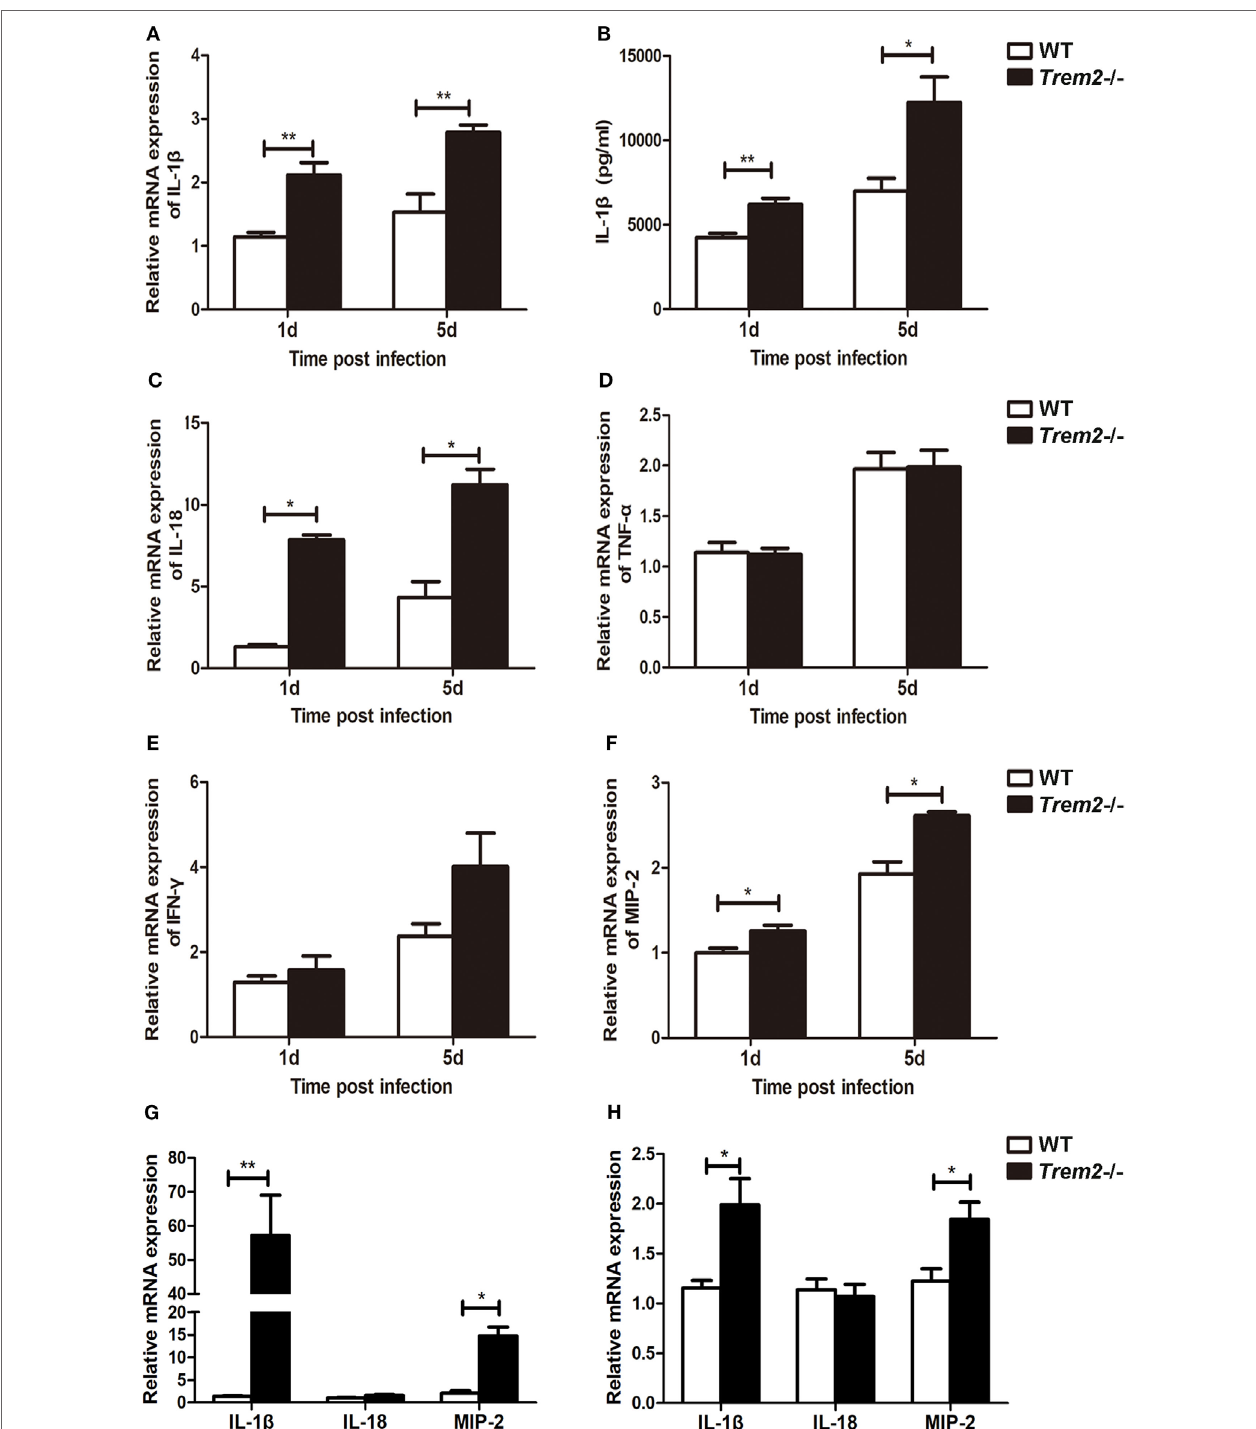
FigUre 2 | Triggering receptors expressed on myeloid cells 2 (TREM-2) inhibited pro-inflammatory cytokine expression after Pseudomonas aeruginosa infection. mRNA expression levels of pro-inflammatory cytokines, including IL-1 β (a) , IL-18 (c) , tumor necrosis factor-alpha (D) , IFN- γ (e) , and MIP-2 (F) was examined by real-time PCR in infected wild type (WT) and Trem2 − / − B6 corneas at 1 and 5 days after infection. (B) Protein level of IL-1 β in WT and Trem2 − / − -infected B6 corneas was tested by enzyme-linked immunosorbent assay at 1 and 5 days after infection. mRNA expression levels of IL-1 β , IL-18, and MIP-2 was examined by real-time PCR in heat-killed P. aeruginos a (HK-PA)-treated WT and Trem2 − / − B6 corneas at 5 days after treatment (g) and WT and Trem2 − / − BMDM (h) which were treatment with HK-PA at an MOI of 5 for 6 h. Data are the mean ± SEM and represent three individual experiments each with five mice per group. * P < 0.05; ** P < 0.01.